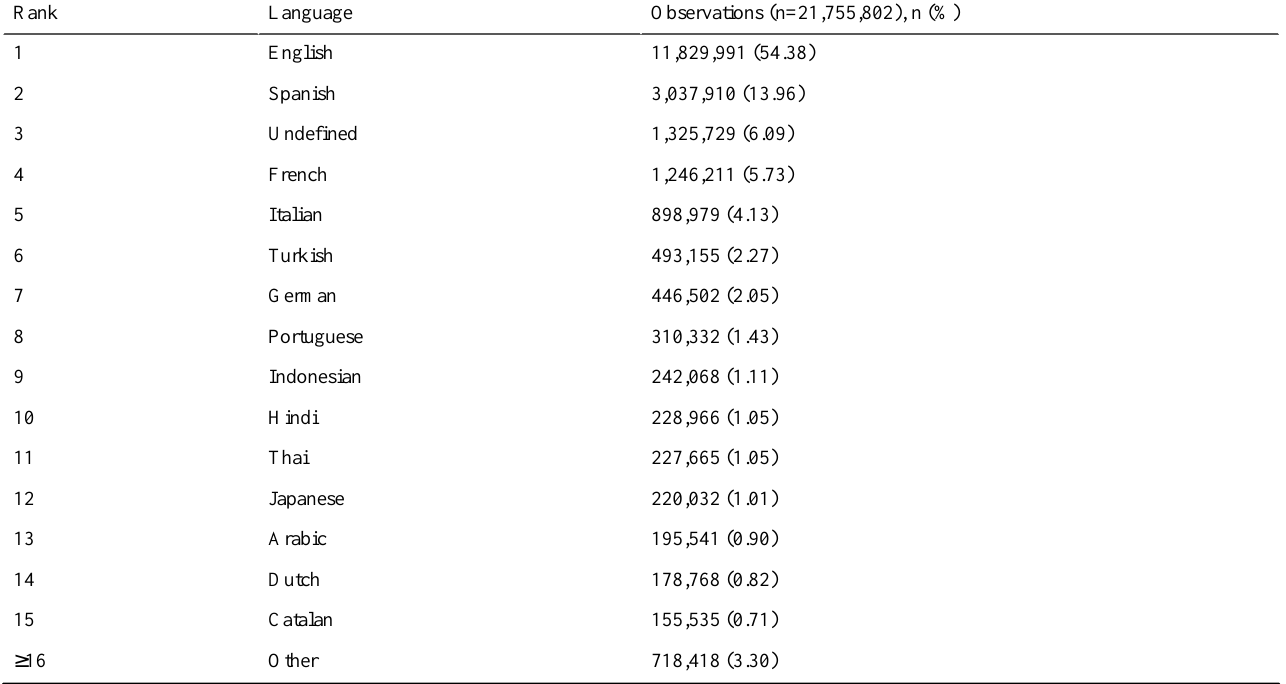
Table 1. Language distribution of the study